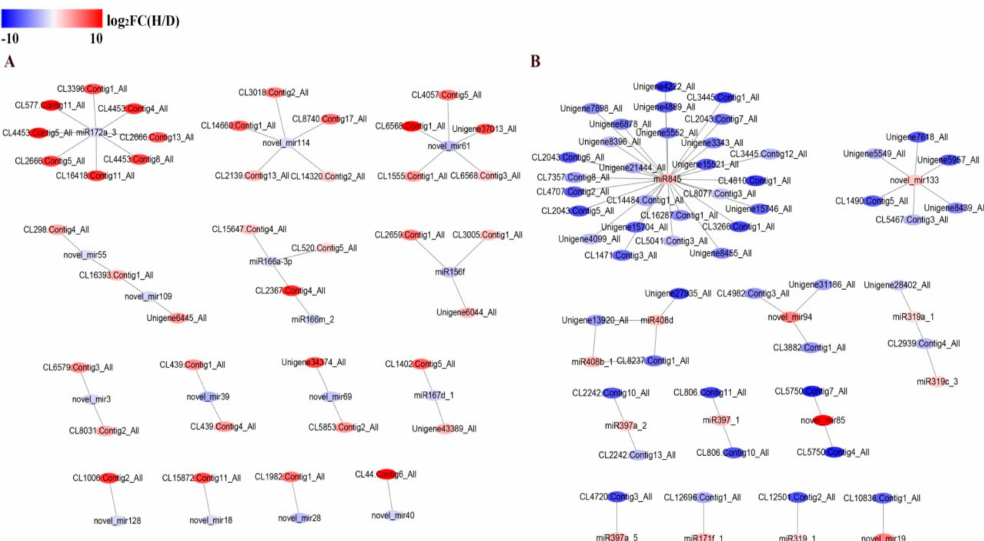
Figure 8. The interaction network of miRNAs with target genes. The down-regulation of miRNAs ( A ) and up-regulation of miRNAs ( B ) negatively correlated with target genes. The color bar indicates the normalized log 2 transformed fold change value between two cytotypes, red indicates up-regulation and blue indicates down-regulation. The color bar indicates the normalized log 2 transformed fold change value of hexaploid compared with diploid. The red indicates up-regulation and the blue indicates down-regulation in hexaploid compared with